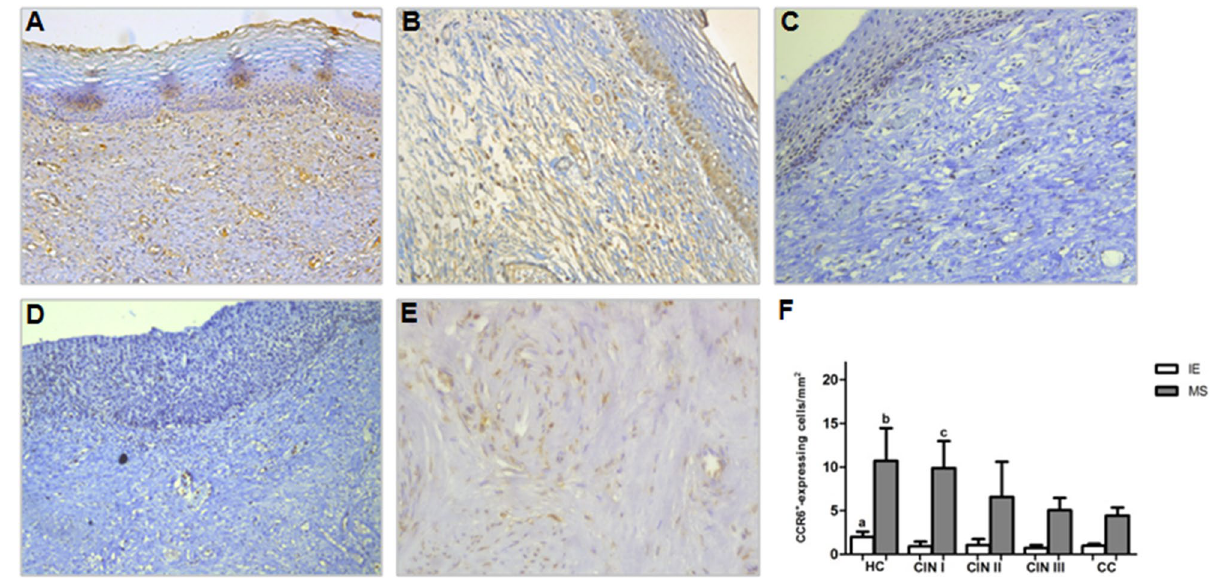
Figure 4. Immunohistochemical staining showing CCR6 + -expressing cells in uterine cervix tissues in IE and MS sites from ( A ) HC, ( B ) CIN I, ( C ) CIN II, ( D ) CIN III, and ( E ) CC. Original magnification = × 20, ( F ) represents the means ± SD of CCL20 expressing cell counts among the groups. a p < 0.05, HC versus CC; p < 0.01, HC versus CIN II; p < 0.001, HC and CIN I and CIN III. b p < 0.05, HC versus CIN II; p < 0.001, HC versus CIN III and CC. c p < 0.01, CIN I versus CIN III; p < 0.001, CIN I and CC. P value was calculated using the nonparametric Kruskal–Wallis test and post-test of Dunns for multiple comparison.